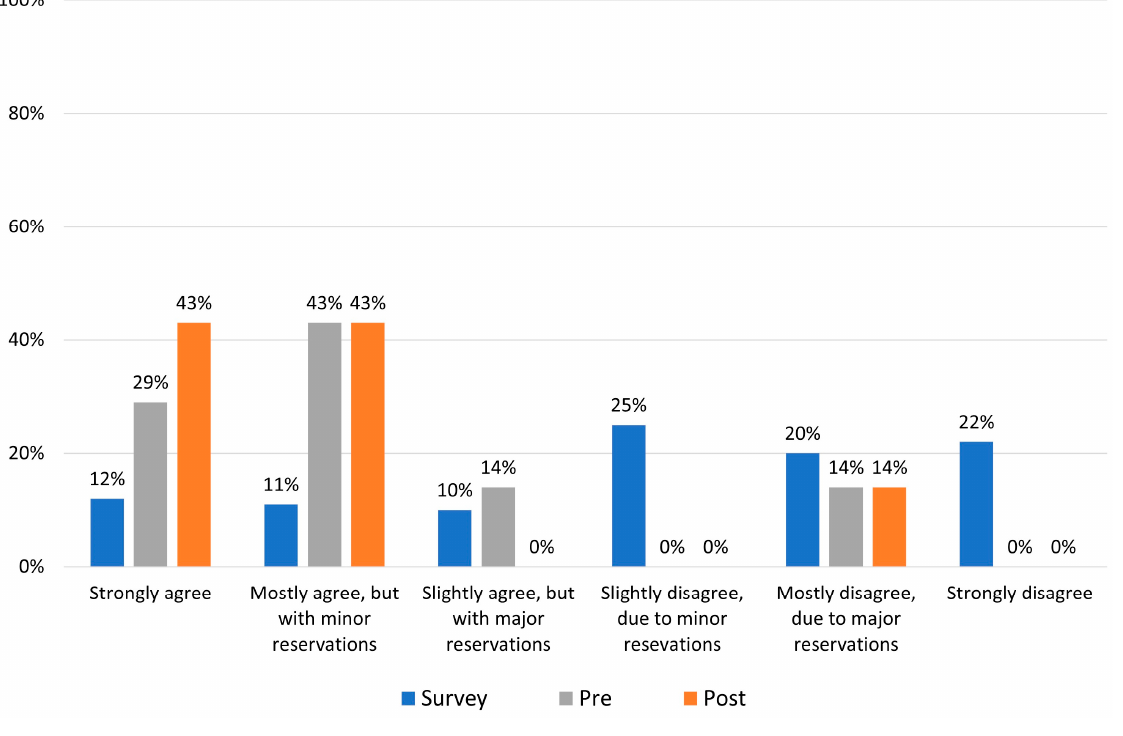
Figure 1. Level of support for the focus statement “ Trazodone should never be used as a first-line medication for insomnia ” for survey respondents (blue bars, n = 508) and for the clinical appraisal panel; pre-meeting (grey bars, n = 7) and post-evidence presentation (orange bars, n = 7).